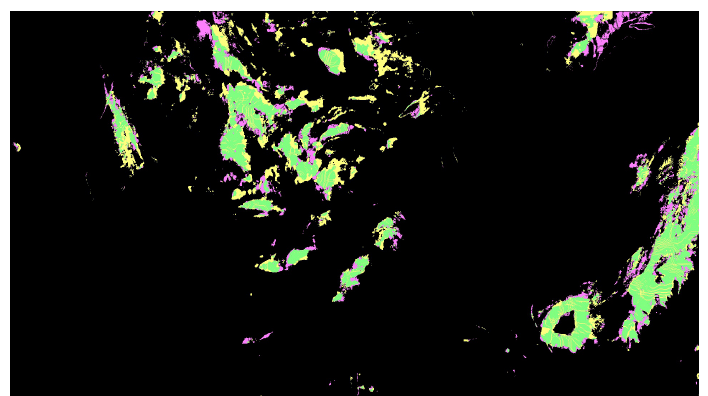
Figure 7. Cloud masks for 1-hour ahead. Heatmap : true positives (green), true negatives (black), false positives (magenta) and false negatives (yellow).